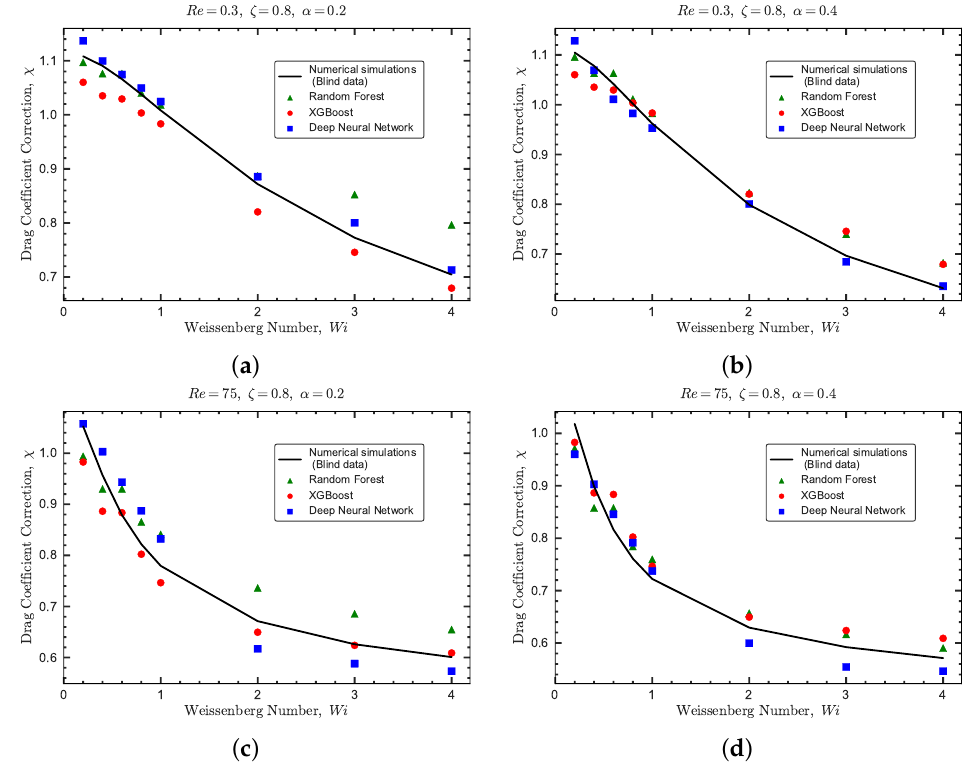
Figure 12. Validation of the ML models against blind datasets generated for Giesekus fluids. The com- parisons are between the DNSs (solid lines showing the real values for the viscoelastic drag coefficient correction) and the predicted values by the ML models. The comparisons are shown at ζ = 0.8 for dif- ferent values of Re and α : ( a ) Re = 0.3 and α = 0.2, ( b ) Re = 0.3 and α = 0.4, ( c ) Re = 75 and α = 0.2, and ( d ) Re = 75 and α = 0.4. The predictions obtained with the Deep Neural Network, Random Forest and XGBoost models are represented by square, triangle and circle symbols,